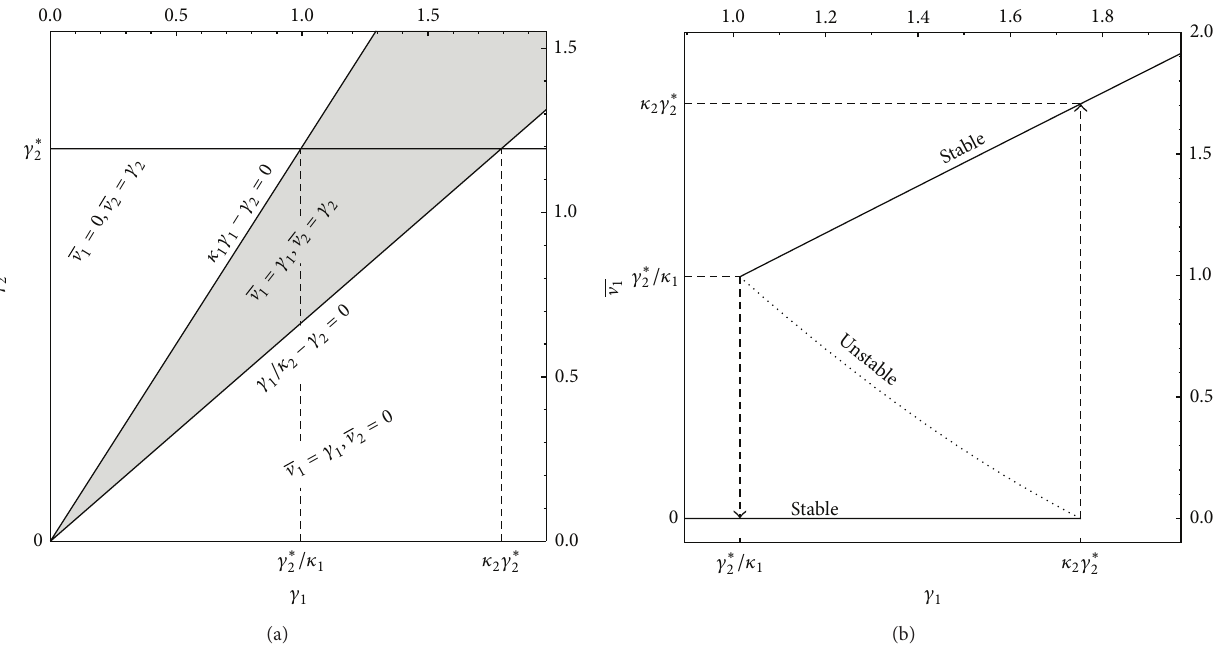
Figure 3: Hysteresis in the two-consumer, two-resource system (1a)–(1d). It takes place in the case of strong coupling 𝜘 1,2 > 1 . (a) The resource-supply parametric plane (𝛾 1 , 𝛾 2 ) . Consumer 1 completely dominates below the line 𝛾 1 − 𝜘 2 𝛾 2 = 0 , whereas consumer 2—above the line 𝜘 1 𝛾 1 − 𝛾 2 = 0 . Both boundary steady states are stable in the region of bistability confined by the two aforementioned lines and marked off by gray, with the dominance of either consumer being a matter of path-dependency. (b) Equilibrium level of consumer 1 as a function of the resource supply. Numerical values of the coupling strengths are chosen to be 𝜘 1 = 1.2 and 𝜘 2 = 1.5